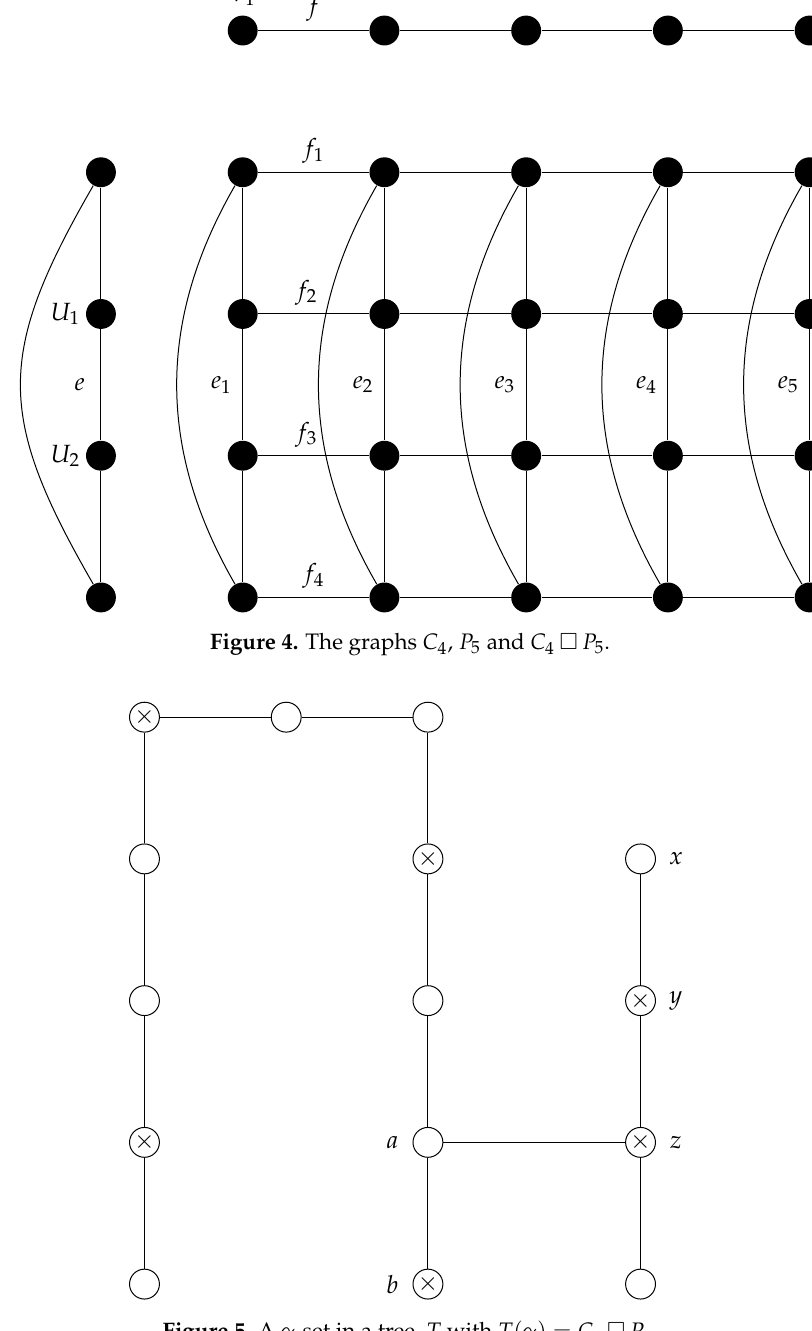
Figure 5. A γ -set in a tree, T with T ( γ ) = C 4 (cid:3) P 5